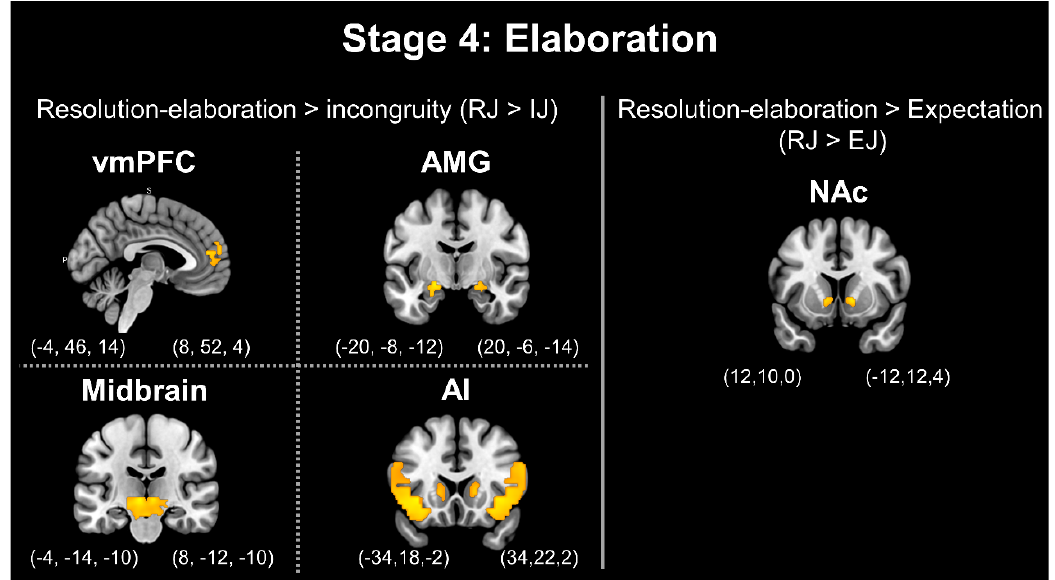
Figure 5. Stage 4: Elaboration. Note: vmPFC = ventromedial prefrontal gyrus; AMG = amygdala; AI = anterior insula; NAc = nucleus accumbens.